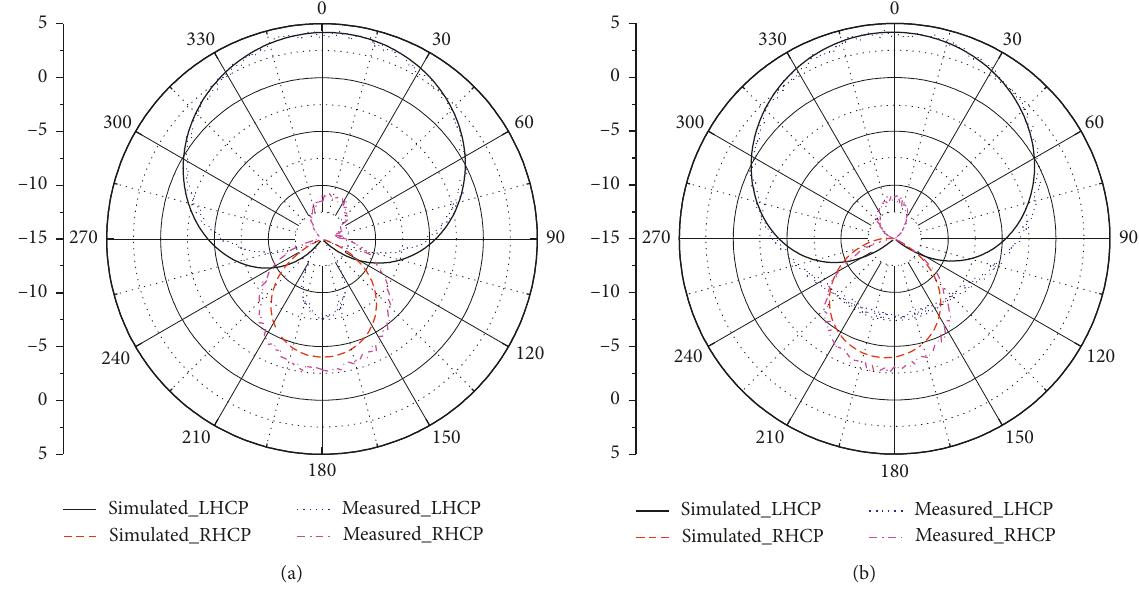
Figure 14: Measured and simulated antenna radiation patterns in the (a) phi � 0deg and (b) phi � 90deg